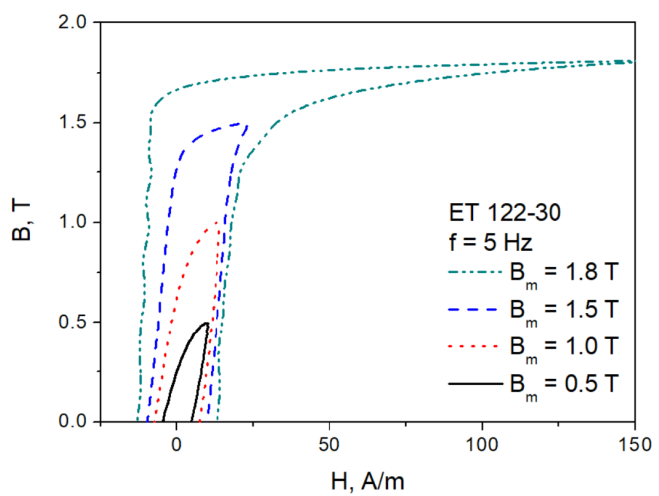
Figure 7. A family of measured hysteresis loops for ET 122-30 GO electrical steel.